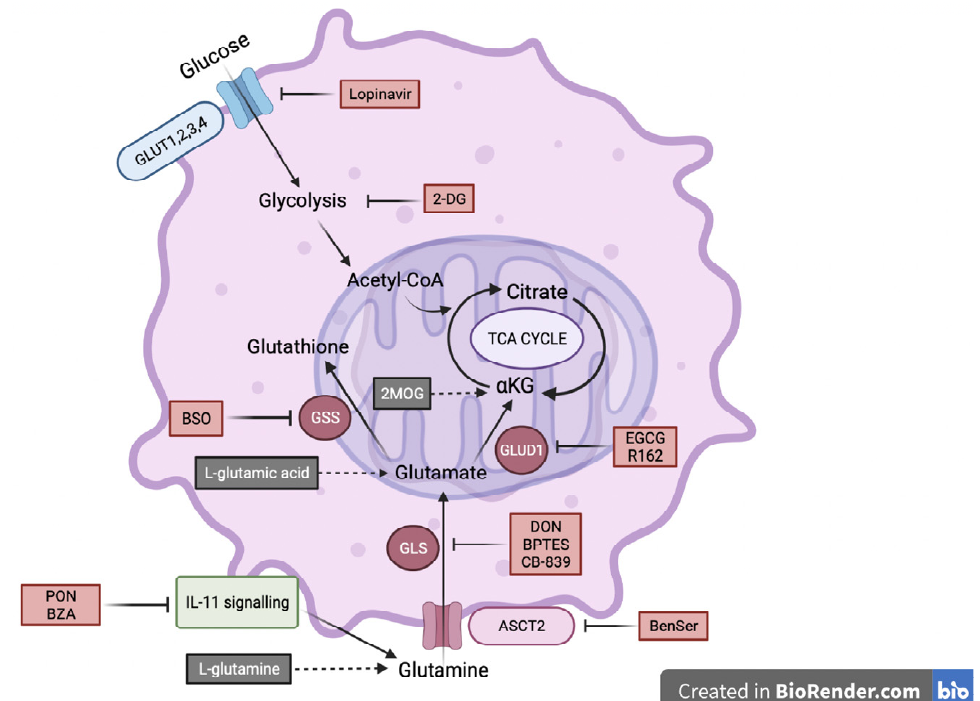
Figure 6. Schematic diagram of IL-11-driven glutaminolysis. IL-11R α promotes enhanced glutamine oxidation and subsequent glutamate production. In turn, this enhanced glutamate generates increases in glutathione. Lopinavir and 2-DG inhibit glucose oxidation. PON and BZA inhibit IL-11 signalling. BenSer, DON, BPTES, CB-839, EGCG, R162 and BSO inhibit glutamine oxidation. This schematic was created with BioRender.com (accessed on 5 December